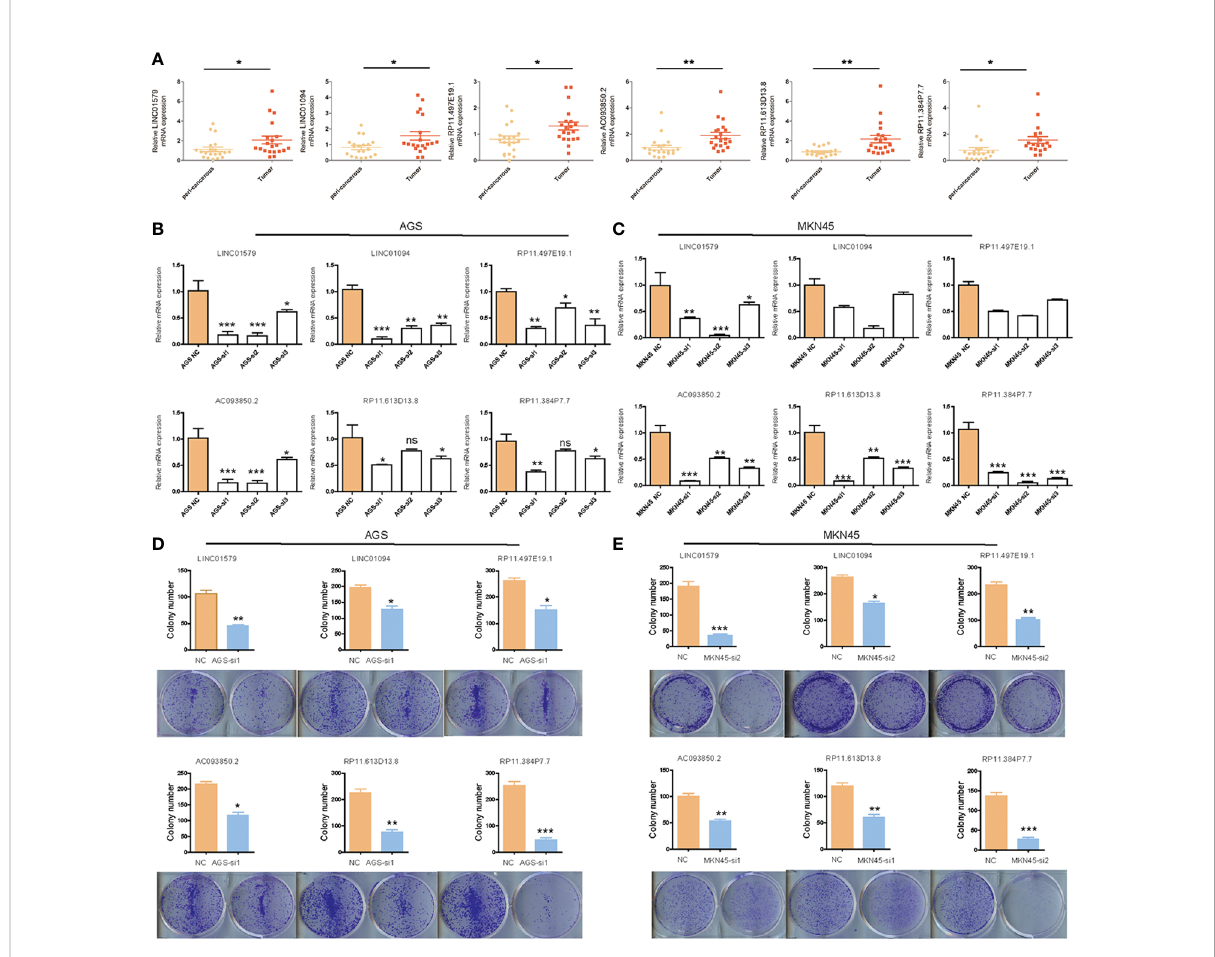
FIGURE 13 The expression and function analysis of six angiogenesis-related lncRNAs. (A) The expression of six angiogenesis-related lncRNAs in STAD by q-PCR; (B) The ef fi ciency of knockdown of six angiogenesis-related lncRNAs in AGS cells validated by q-PCR; (C) The ef fi ciency of knockdown of six angiogenesis-related lncRNAs in MKN45 cells validated by q-PCR; (D) The in fl uence of six angiogenesis-related lncRNAs knockdown on colony-formation ability of AGS cells; (E) The in fl uence of six angiogenesis-related lncRNAs knockdown on colony-formation ability of MKN45 cells. Differences between the two groups were analyzed using the independent t-test, values are expressed as the means±sem. ns, P>0.05; *P < 0.05; **P < 0.01; ***P < 0.001; ****P <